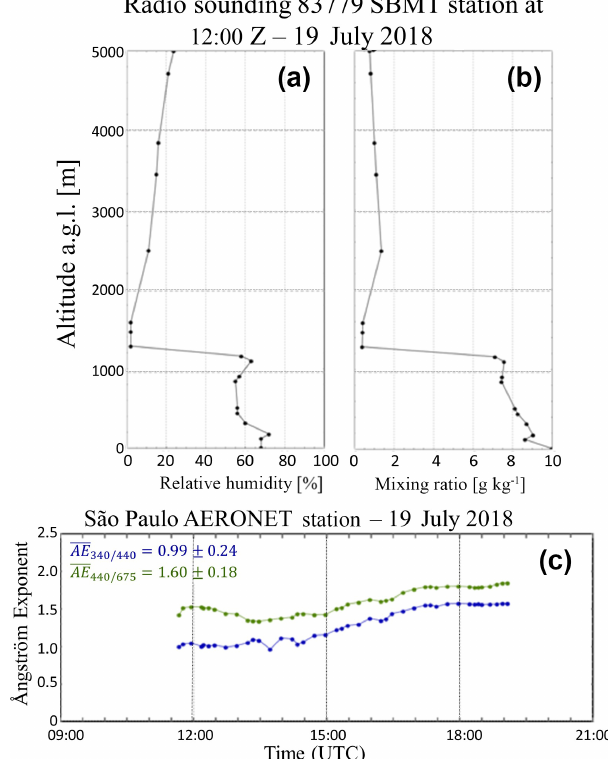
Figure 9. (a) Vertical profile of relative humidity derived from radio sounding. (b) Mixing ratio derived from radio sounding. (c) Aerosol-optical-depth-related Ångström exponent time series from AERONET, for measurements retrieved at 19 July 2018.